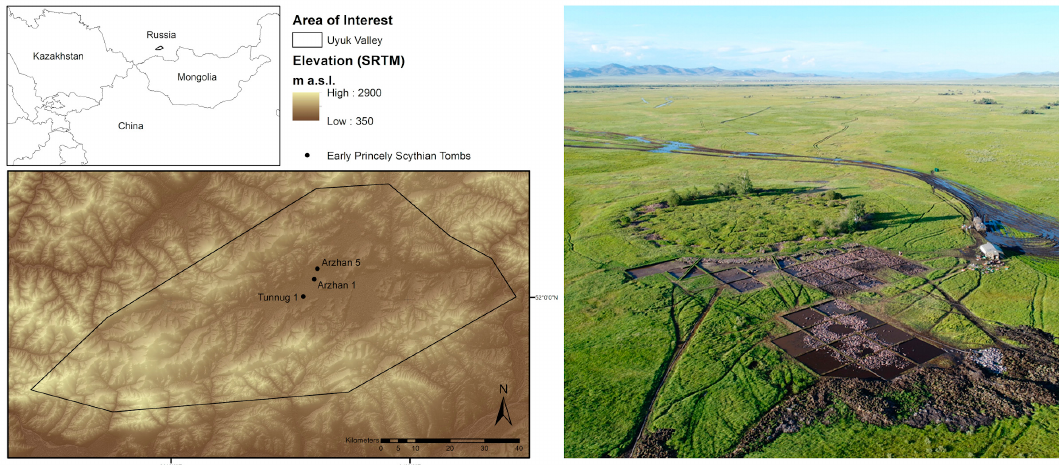
Figure 1. ( left ) Overview over the Uyuk Valley and the earliest known royal Scythian burial mounds in the Eurasian steppe mentioned in the text. ( right ) Aerial view of the burial mound Tunnug 1 with the 2018 excavation quadrants in the southern periphery (looking northeast) Photo: J. Blochin.